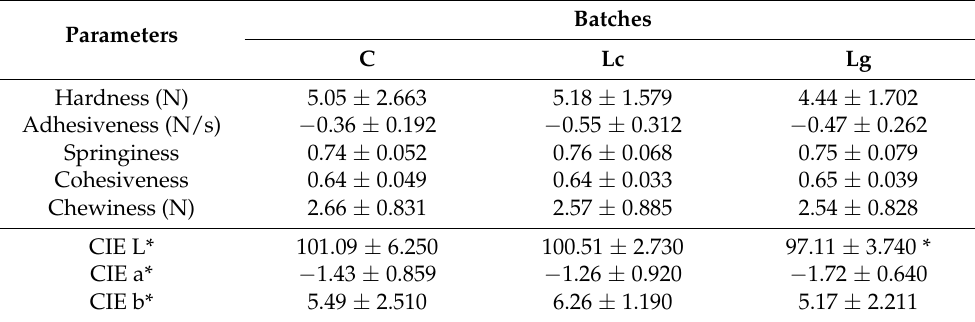
Table 5. Values of instrumental texture (hardness, adhesiveness, springiness, cohesiveness and chewiness) and color parameters of “Torta del Casar” cheese at the end of the ripening process. Parameters